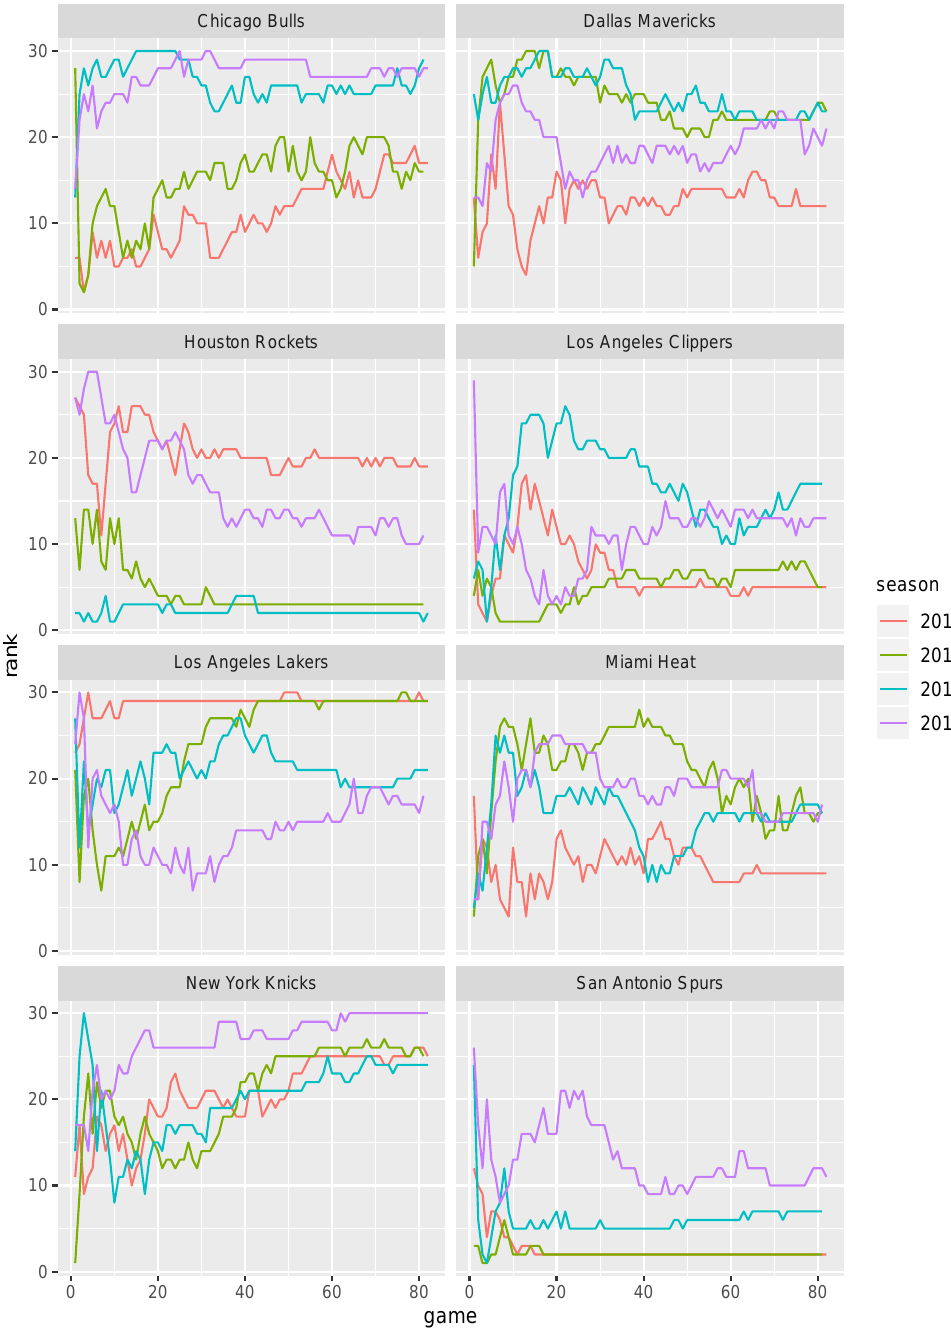
Figure 4. Ranking results for eight teams from 2015 to